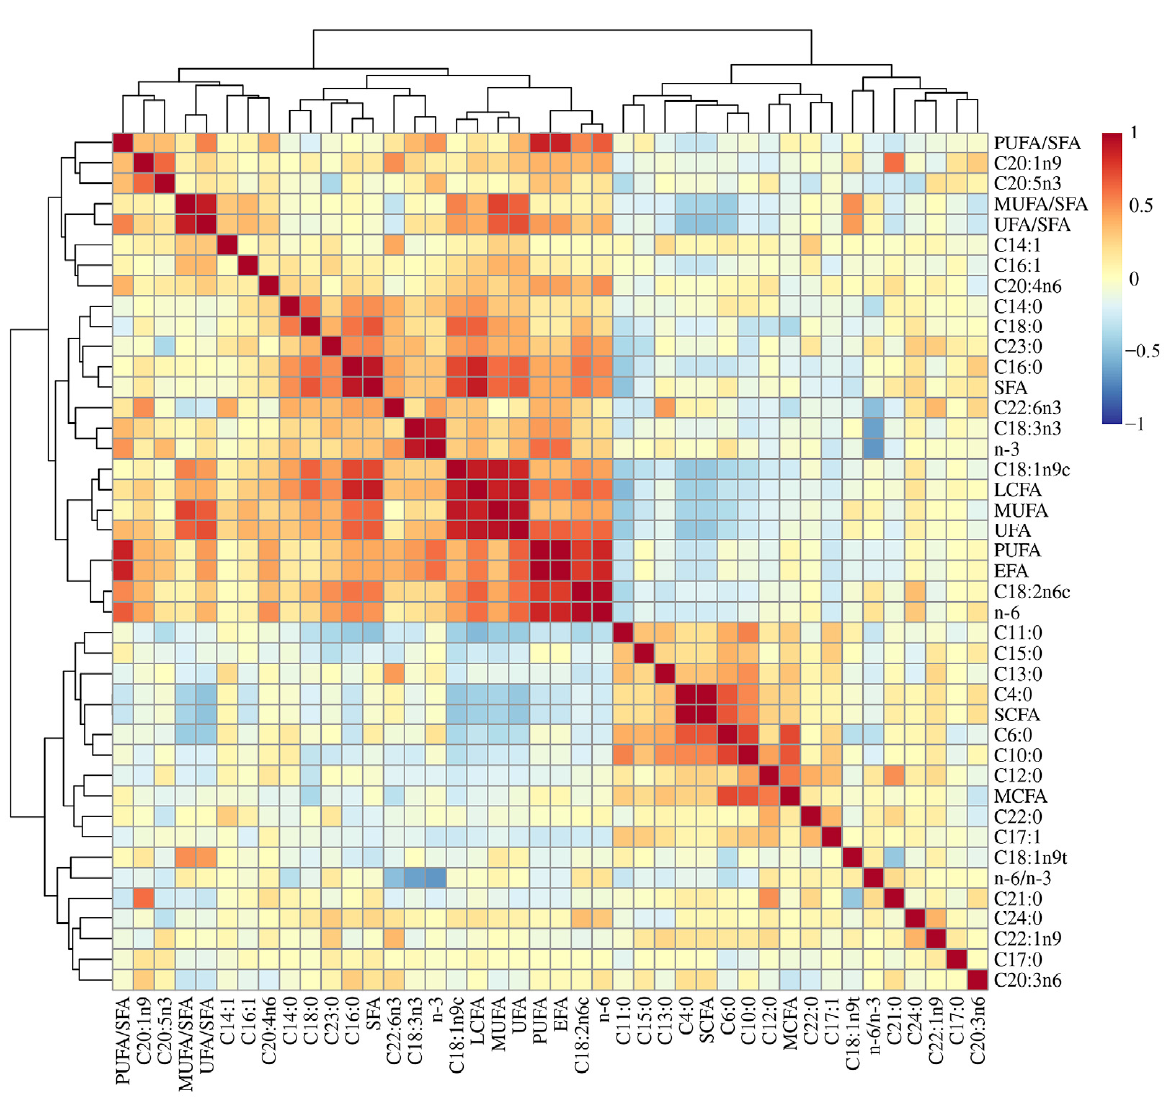
Figure 1. Correlogram of the correlation analyses between any two traits of FA compositions and classes. The correlation matrix was reordered according to the correlation coefficient, aiming to make the clusters of correlated variables more evident. Positive correlations are displayed in red and negative correlations in blue color. The color intensity and size of circles are proportional to the size of the correlation coefficients.